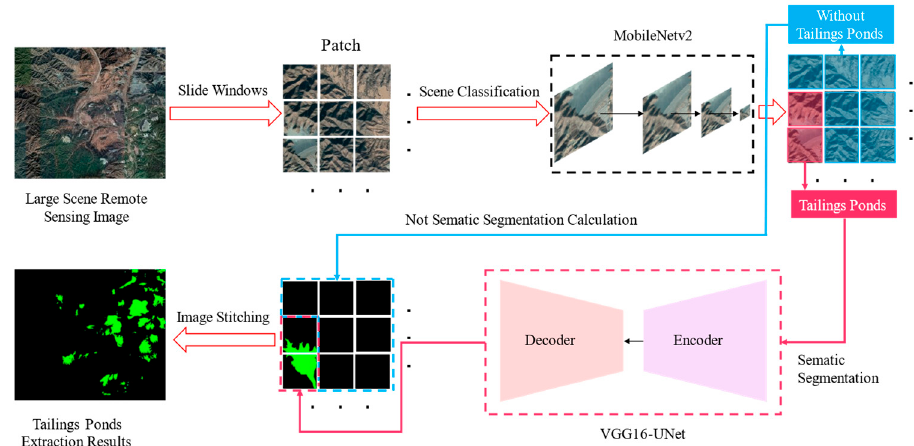
Figure 1. Flow chart of tailings ponds extraction from remote sensing images of large scenes based on the SC-SS model.